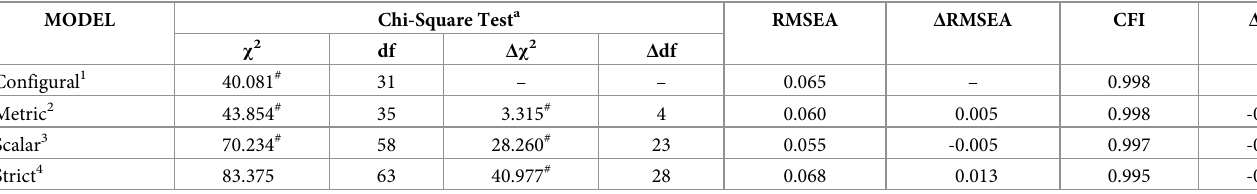
Table 4. Longitudinal invariance: Models’ fit (across T1 and T2).